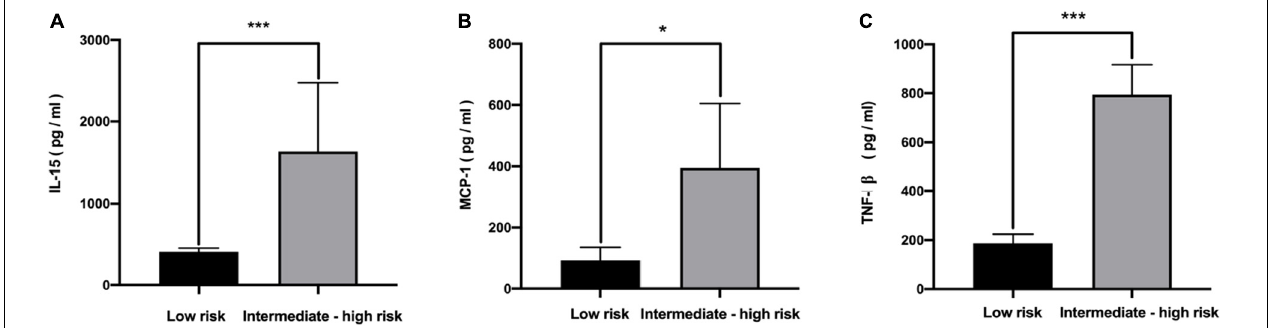
FIGURE 3 | The concentration of serum IL-15 (A) , MCP-1 (B) , and TNF- β (C) between low risk and intermediate-high risk patients. * P < 0.05; *** P < 0.01. IL-15, interleukin 15; MCP-1, monocyte chemoattractant protein-1; TNF- β , tumor necrosis factors- β .